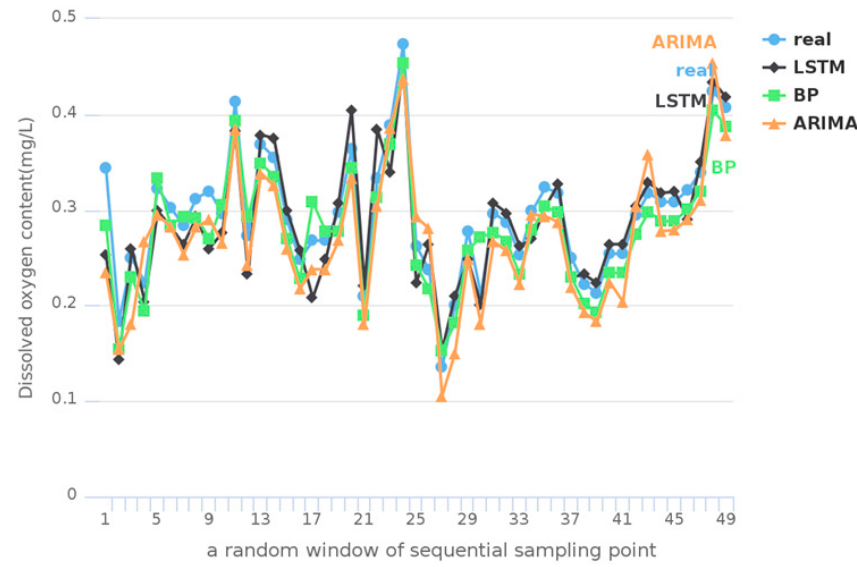
Figure 5. Prediction results of Victoria Bay.